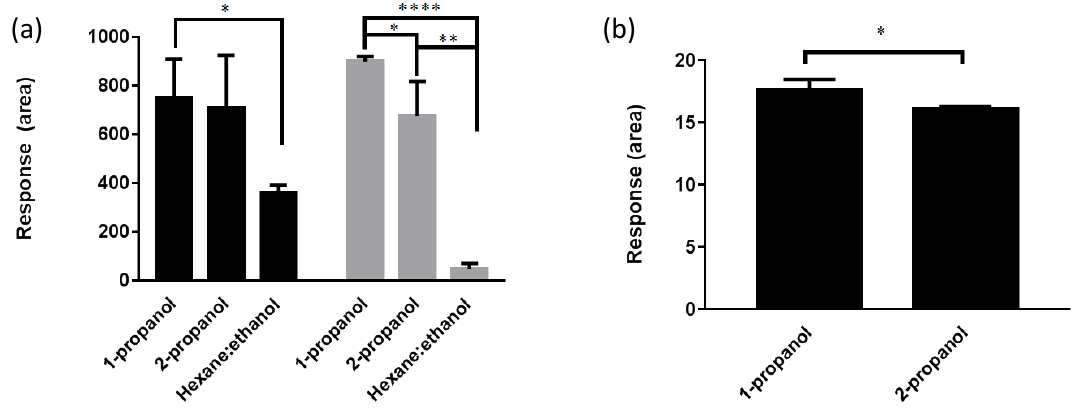
Figure 2. ( a ) Extraction of CoQ 10 H 2 ( ▀ ) and CoQ 10 ( ▀ ) from canine heart tissue ( n = 3); ( b ) Extraction of CoQ 10 H 2 ( ▀ ) from plasma ( n = 3). * means p ≤ 0.05, ** means p ≤ 0.01, **** means p ≤ 0.0001.